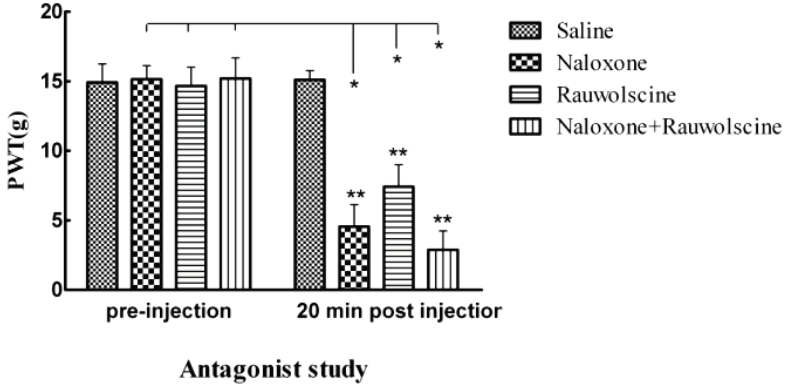
Figure 3. Effect of naloxone and rauwolscine on the degree of mechanical allodynia of bone cancer rats with micro-HPC. On day 20, all rats were first tested and separated randomly into four groups. The rats were then administered saline (10 μ L, i.p.), naloxone (500 μ g/kg, i.p.), rauwolscine (30 μ g/10 μ L, i.p.), and both naloxone and rauwolscine,